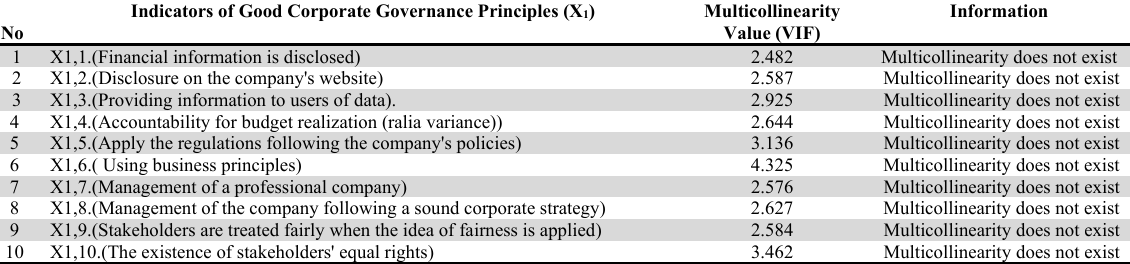
Validity and Reliability Test Results for variables with formative